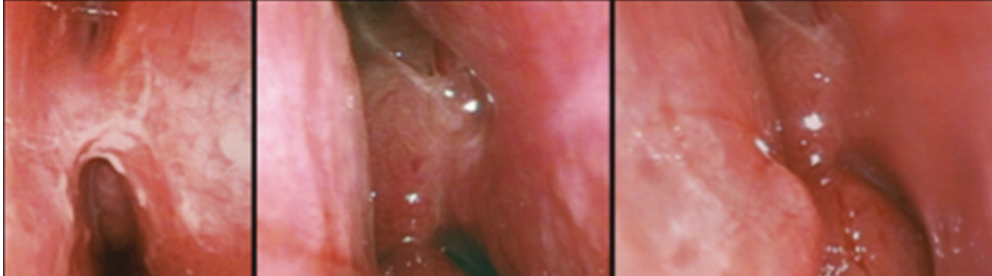
Figure 3: Endoscopic photograph showing right endonasal synechia. On last followup, 2 years postoperatively, lacrimal drainage remained patent without recurrence of synechia. He was followed in ophthalmology for anterior uveitis, but was otherwise